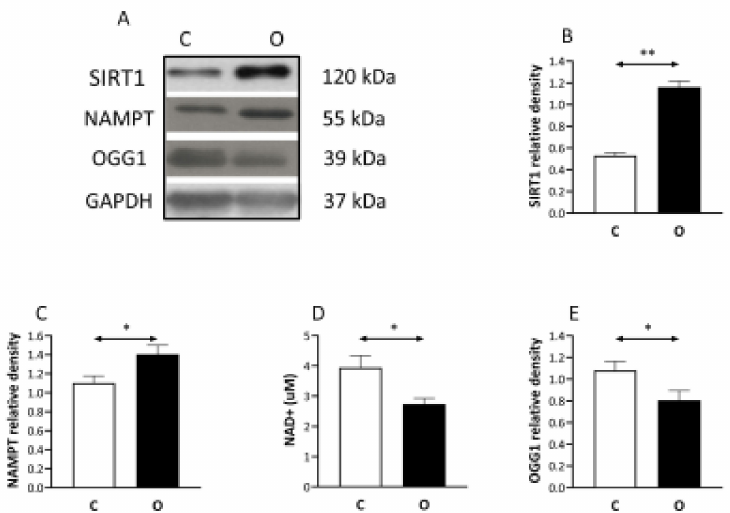
Figure 4. SIRT1 induced by muscle hypertrophy but OGG1 is suppressed. SIRT1 is a NAD + depen- dent histone deacetylase, therefore we measured nicotinamide phosphoribosyltransferase (NAMPT) which is a rate-limiting enzyme in the NAD + salvage pathway. The levels of SIRT1, NAMPT in- creased, while NAD + contents decreased as a result of muscle hypertrophy, suggesting a regulatory role of SIRT1 in overload induced hypertrophy. ( A ) panel shows the selected immunoplot signals, and ( B – E ) panels show the densitometric results of nine samples in each group. C: control group, O: Overloaded group, n = 9, * p <0.05, ** p < 0.01, Results are expressed as mean ± SE.